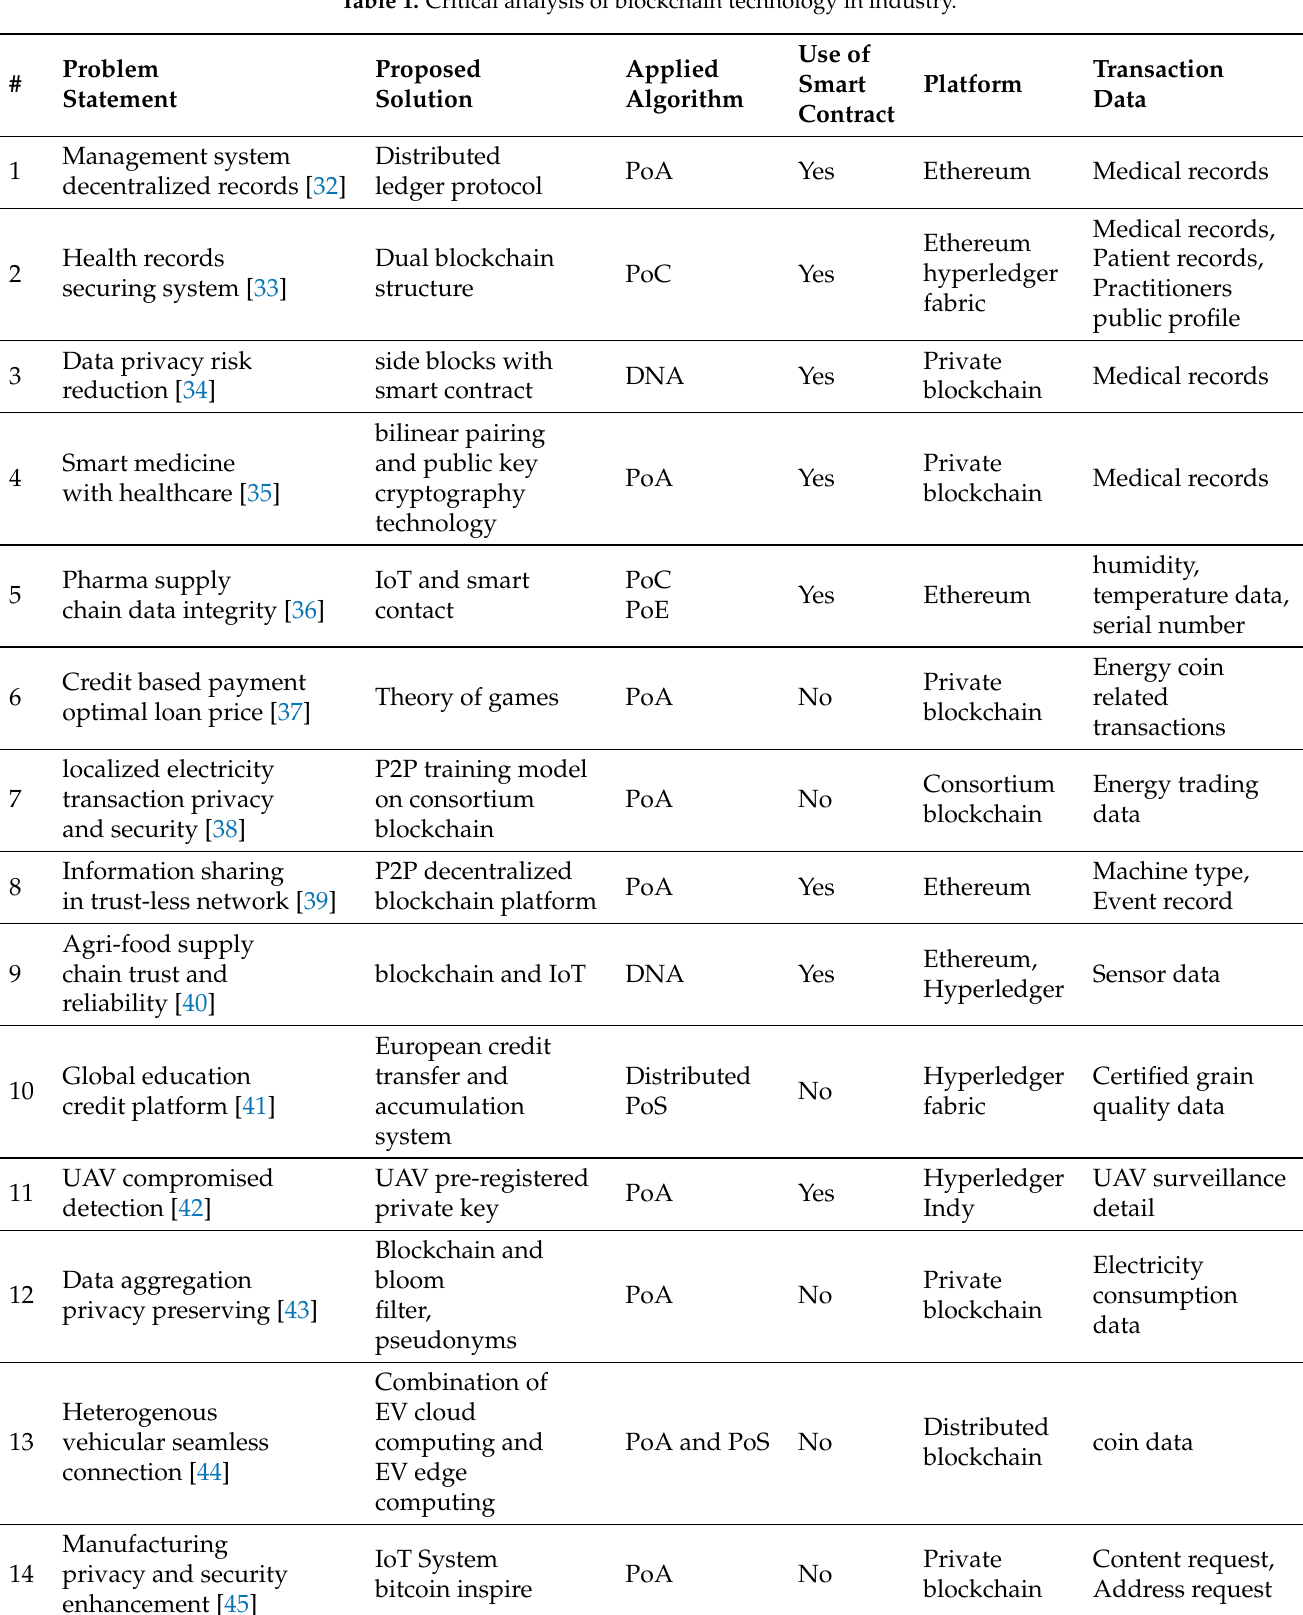
Table 1. Critical analysis of blockchain technology in